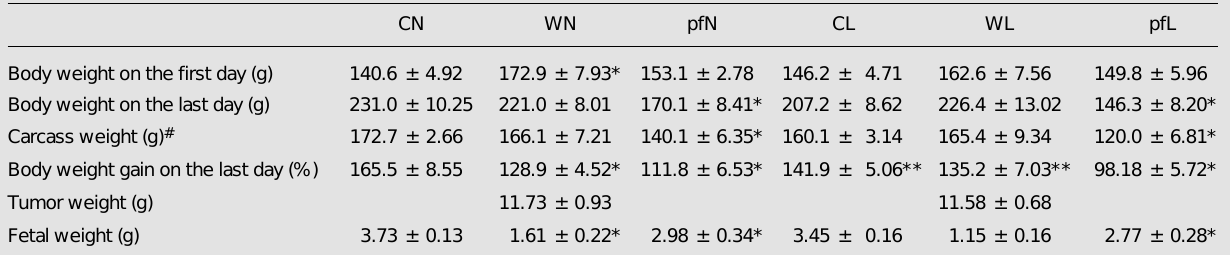
Table 1 - Body and carcass weight, body gain, tumor and fetal weight of the pregnant groups studied. Data are reported as means ± SEM for 10 animals per group. Groups: control (CN); bearing a Walker 256 carcinoma (WN); control pair-fed to tumor- bearing groups (pfN); control receiving a leucine-supplemented diet (CL); tumor-bearing rats receiving a leucine-supplemented diet (WL), and leucine pair-fed groups (pfL). # Carcass weight represents the total body weight minus placentas, fetus, uterus, intestinal tract and tumor tissue. *P<0.05 compared to control groups; **P<0.05, CN vs CL or WN vs WL (Kruskal-Wallis test followed by the Dunn test). WN Body weight on the first day